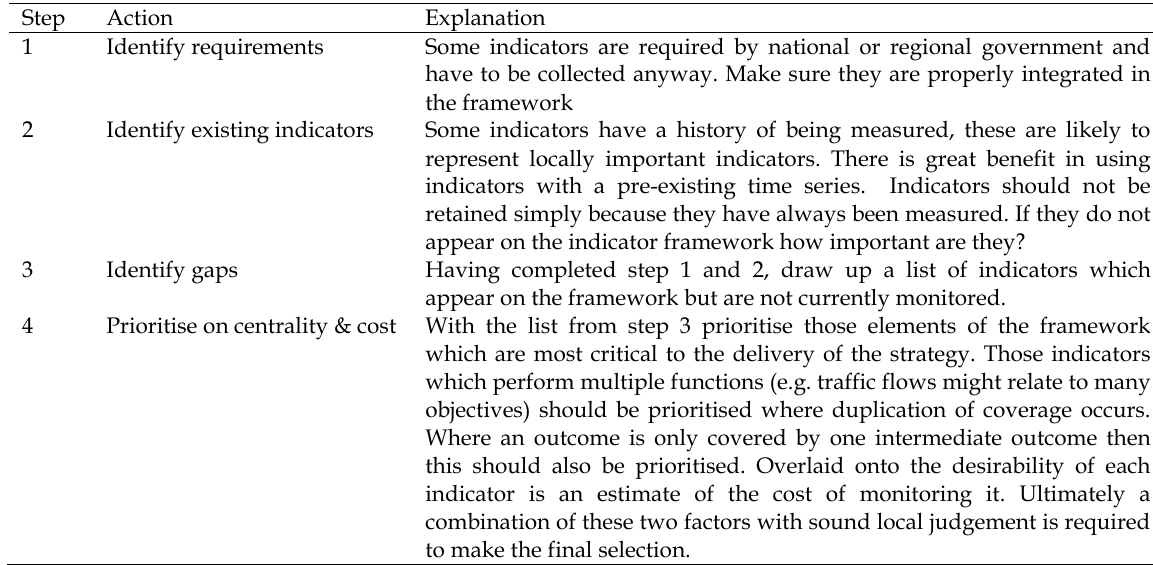
Table 1. Prioritising